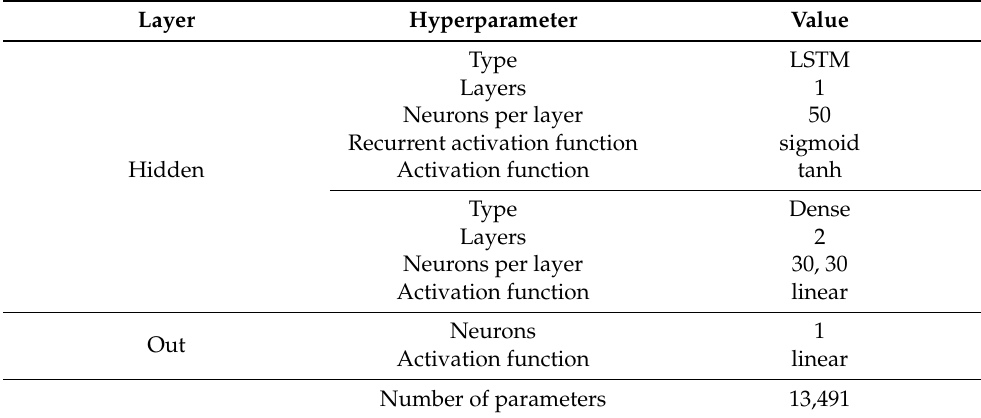
Table 5. Idriss’s architecture hyperparameters [22].